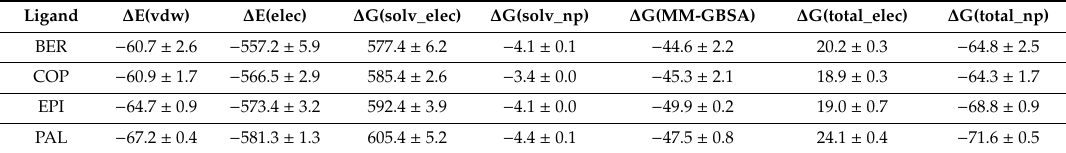
Table 2. MM-GBSA Binding free energies and their components computed using the Amber force field OL15 parameters. Units: kcal /